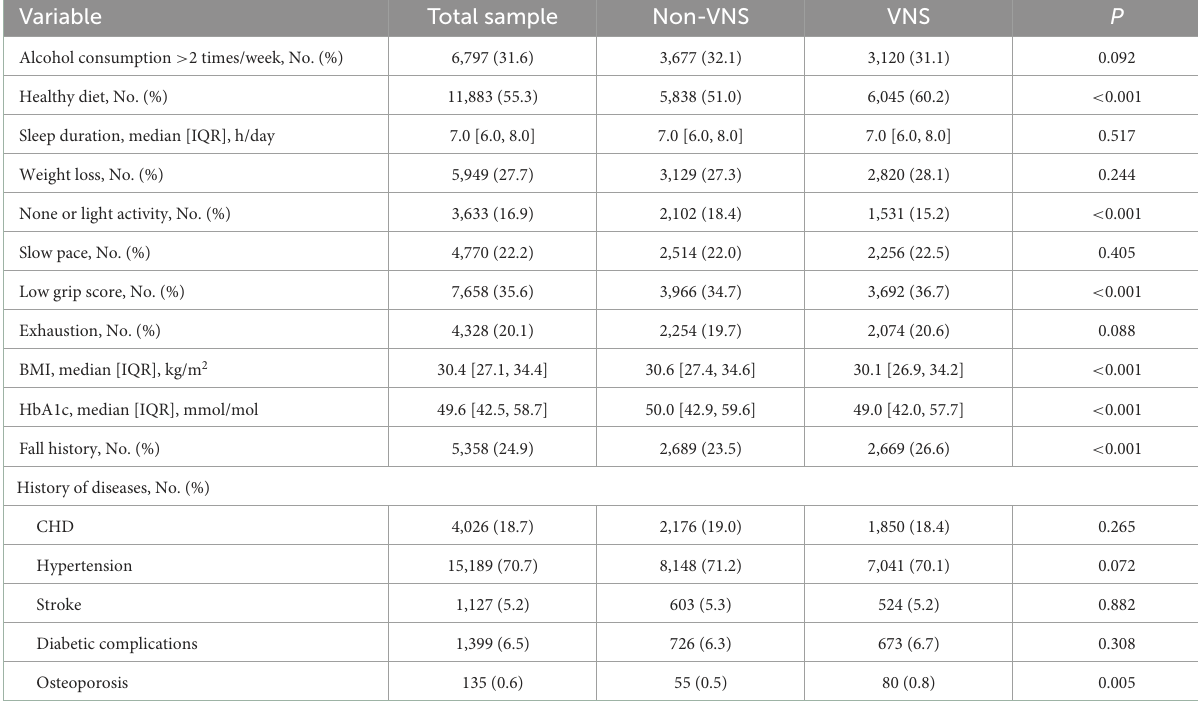
(Table 1). At baseline, 10,047 (46.8%) patients regularly used VNS, in which 6,071 habitually used vitamins (448 for vitamin 587 for vitamin E, and 617 for folate) and 8,387 habitually used mineral supplements. Compared with non-users, participants who used VNS were more likely to be female, older, non-white and less deprived. They were prone to have healthier lifestyles, fatigue phenotypes, lower BMI, lower HbA1c levels, and fall history. After propensity matching, 18,222 participants were identified, with 9,111 in each group (Supplementary Table